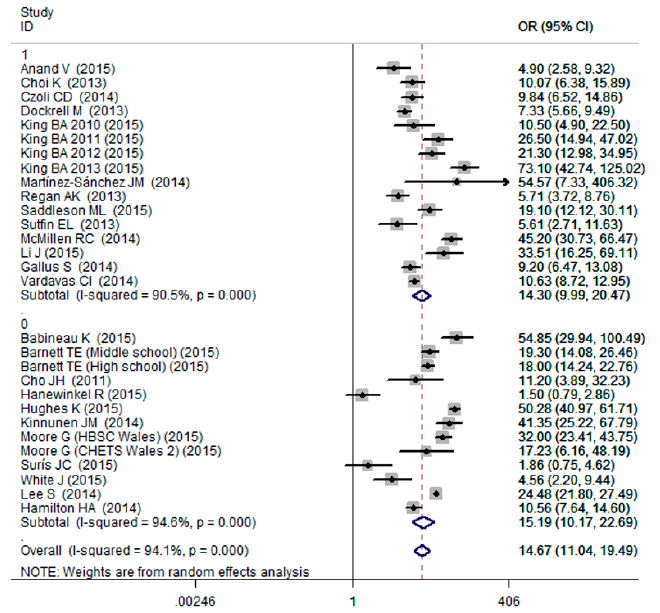
Figure 4. Effects of cigarette smoking on ever e-cigarettes use among adolescents and adults (0: adolescent; 1: adult).